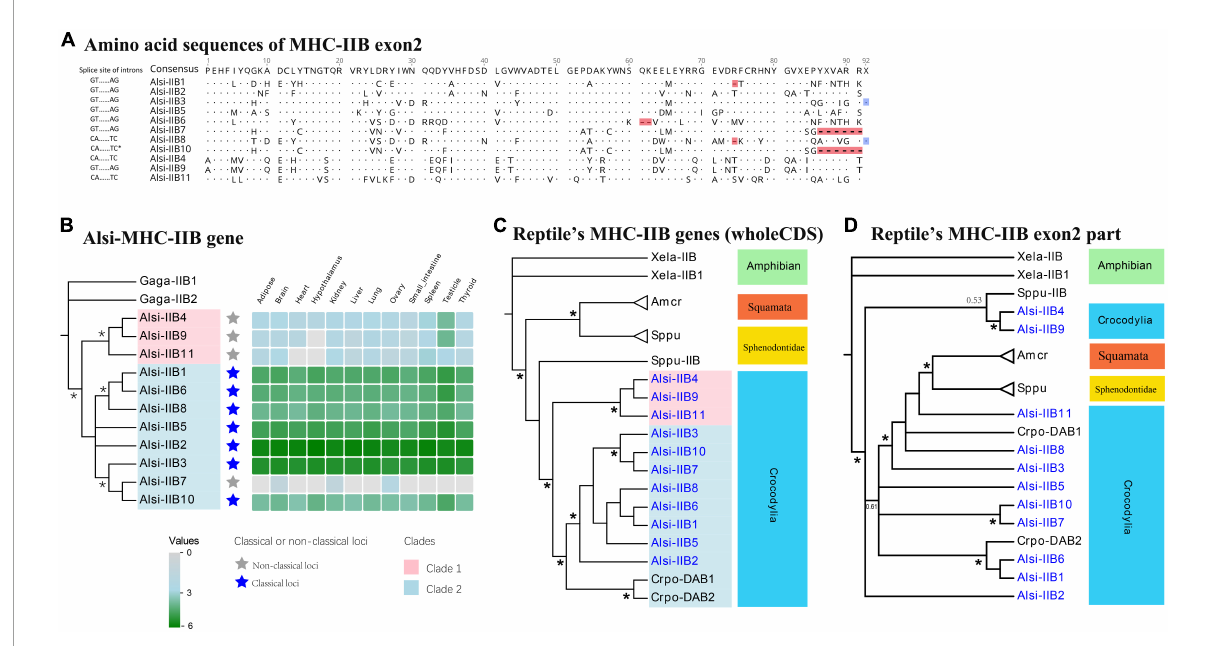
FIGURE6 The phylogenic evolution and expression of MHC-IIB genes in the Chinese alligator. (A) Amino acid sequences and exon/intron splice signals in MHC-IIB exon 2. Deletions and insertions are marked with red and blue, respectively. Phylogenetic evolution of MHC-I genes in (B) Chinese Alligator, (C) in reptiles using the whole CDS, and (D) in reptiles using the antigen-presenting exon 2. Explanatory notes are the same as in Figure 5 . Stars on phylogenetic trees suggest bootstrap values >